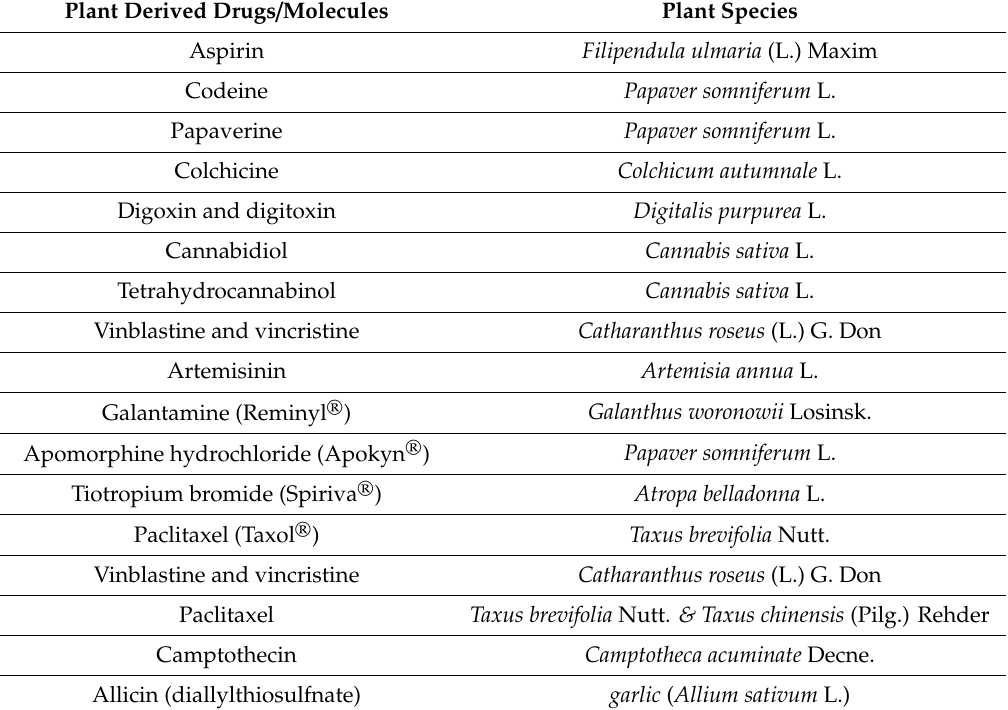
Table 2. Examples of successful drugs derived from medicinal plants. Plant Derived Drugs /